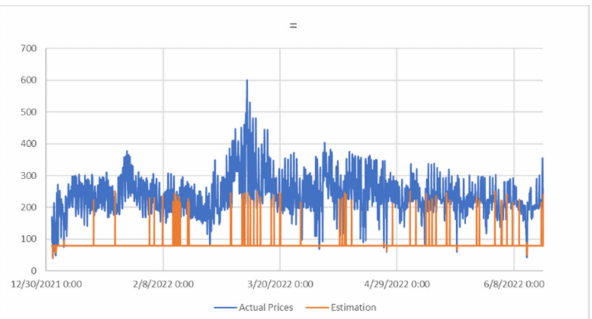
Figure 8. Estimated Prices for the second period when the reference price is 80 EUR/MWh (EUR/MWh).